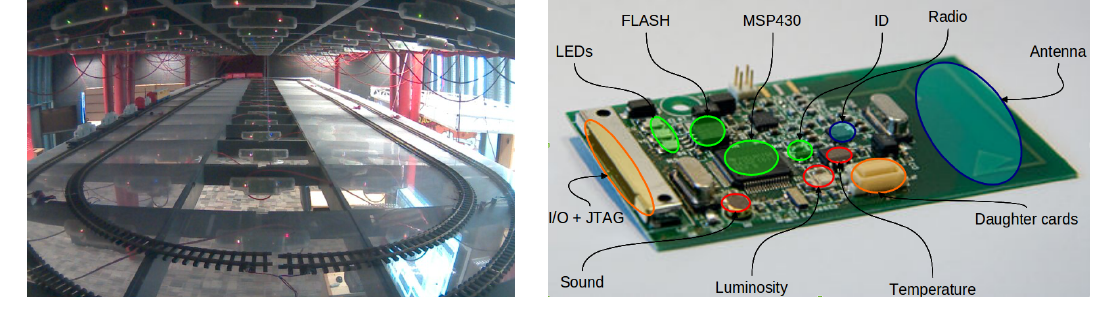
Figure 4. Experimental